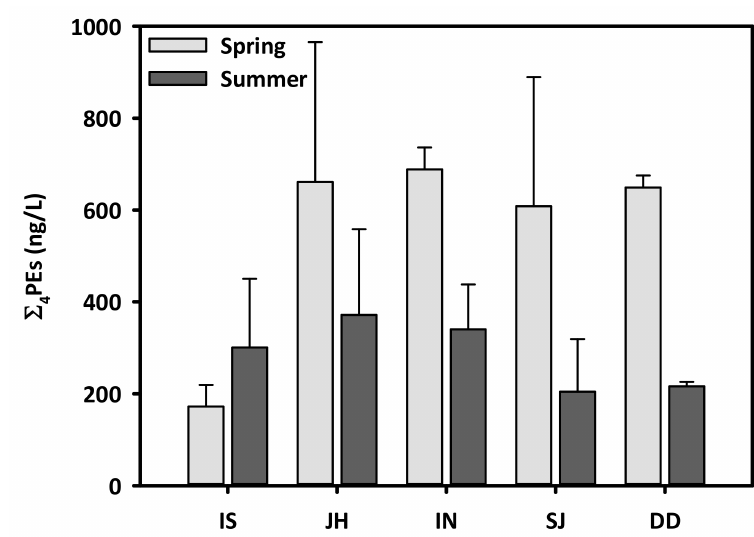
(cid:80) 4 PEs) in the seawater of five beaches in the